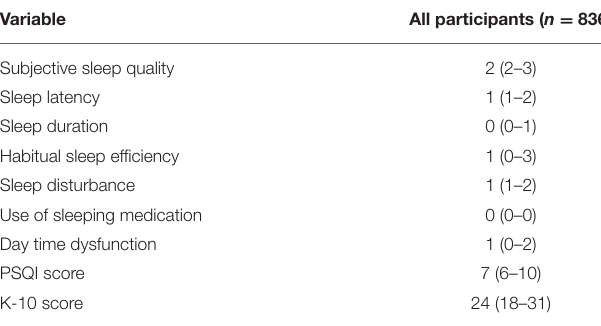
TABLE 2 | PSQI score component and K-10